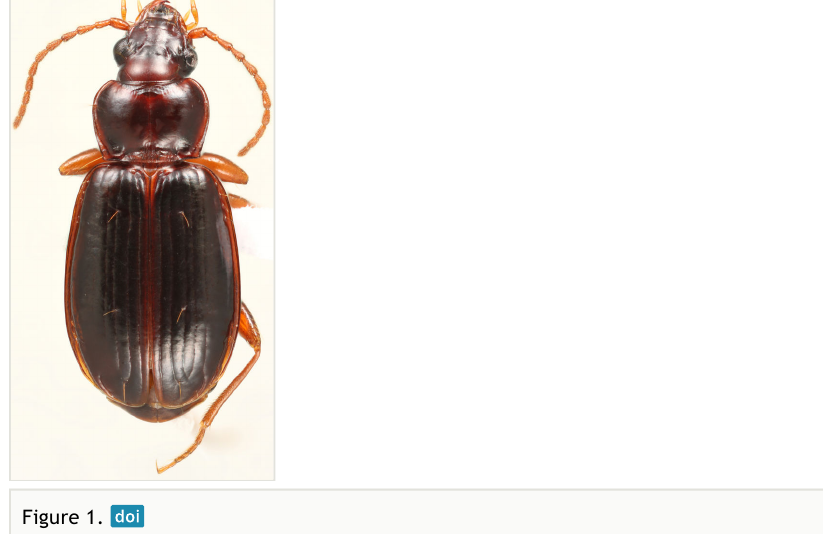
Trechus ( Trechus ) tenuiscapus Lindroth, 4.9 mm long male collected along the Bristelcone Pine trail, GBNP (EMEC344626). This species was found during the study and is a new state record for Nevada from Great Basin National